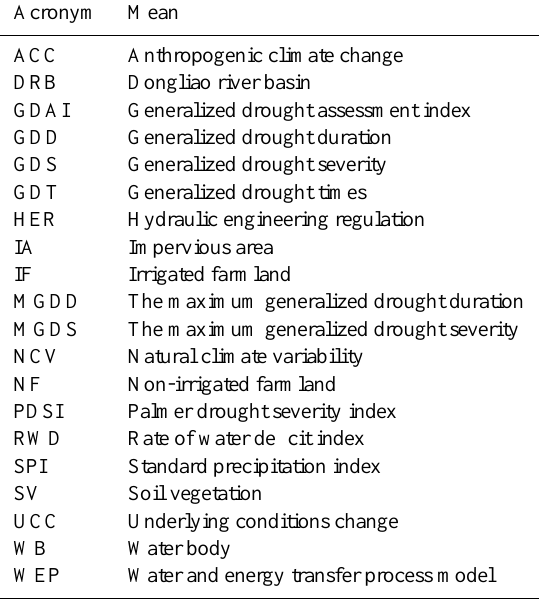
Table A1. All acronyms used in this paper.